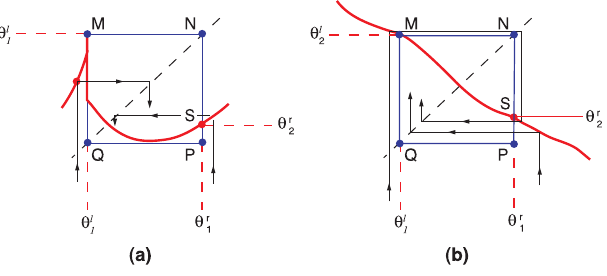
FIG. 6. A square of stability for the case B